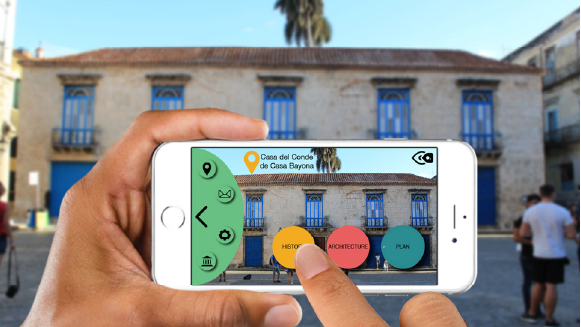
Figure 15. Example of an application of aumented reality